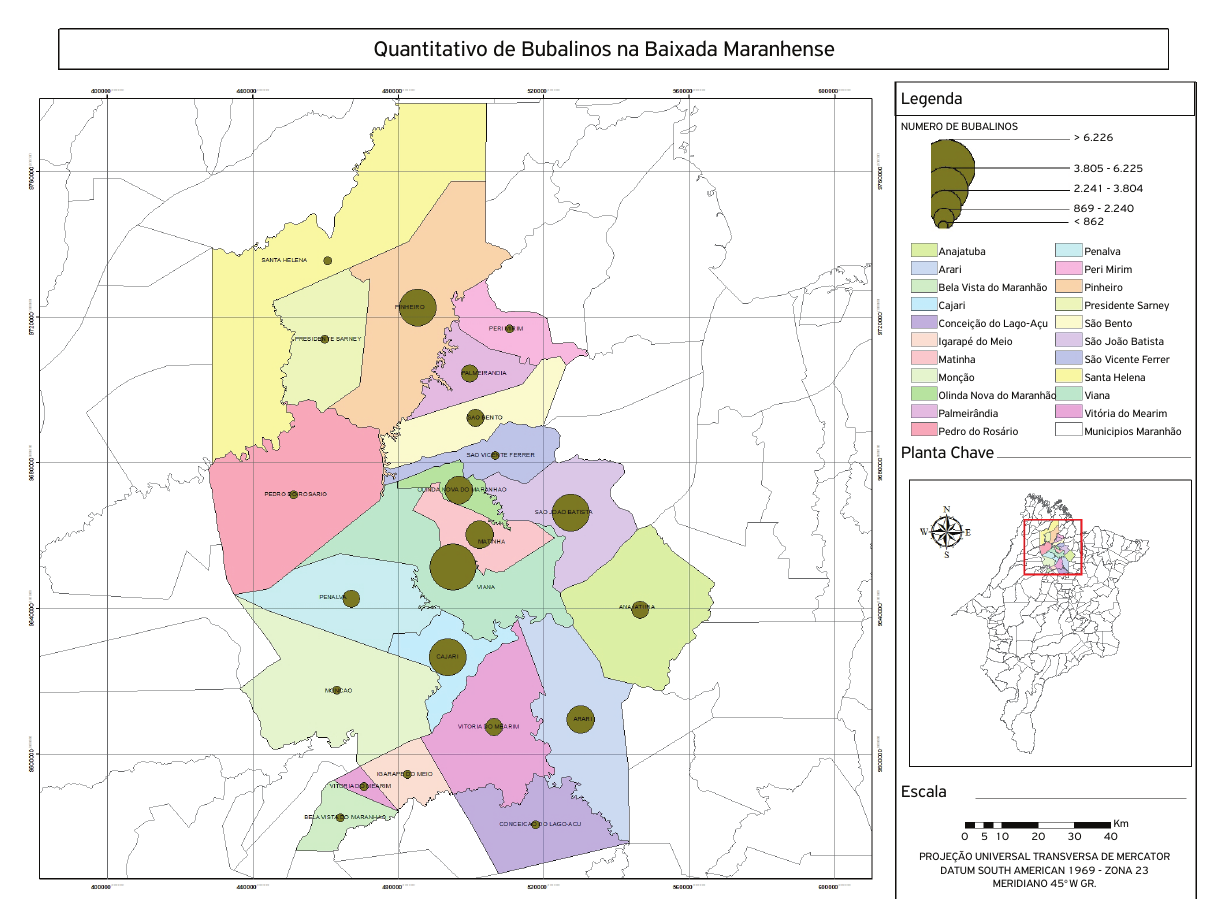
Figura 1. Quantitativo de bubalinos ( Bubalus bubalis ) para corte na Baixada Maranhense,